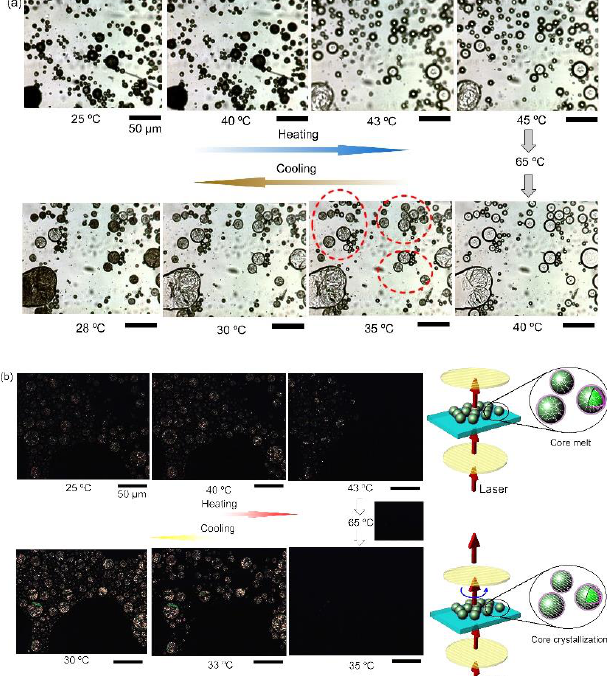
Figure 7. Real-time optical images of the n -eicosane-encapsulated microcapsules during heating–cooling process under transmission mode ( a ) without and ( b ) with polarizers. The heating–cooling rate is 5 ◦ C · min − 1 . The circuit (in red) marked in ( a ) shows the crystals appearing inside capsules. The insets in ( b ) illustrate the melting and crystallizing differences of the capsules and the laser routes, respectively. The inserted scale bars stand for 50 µ